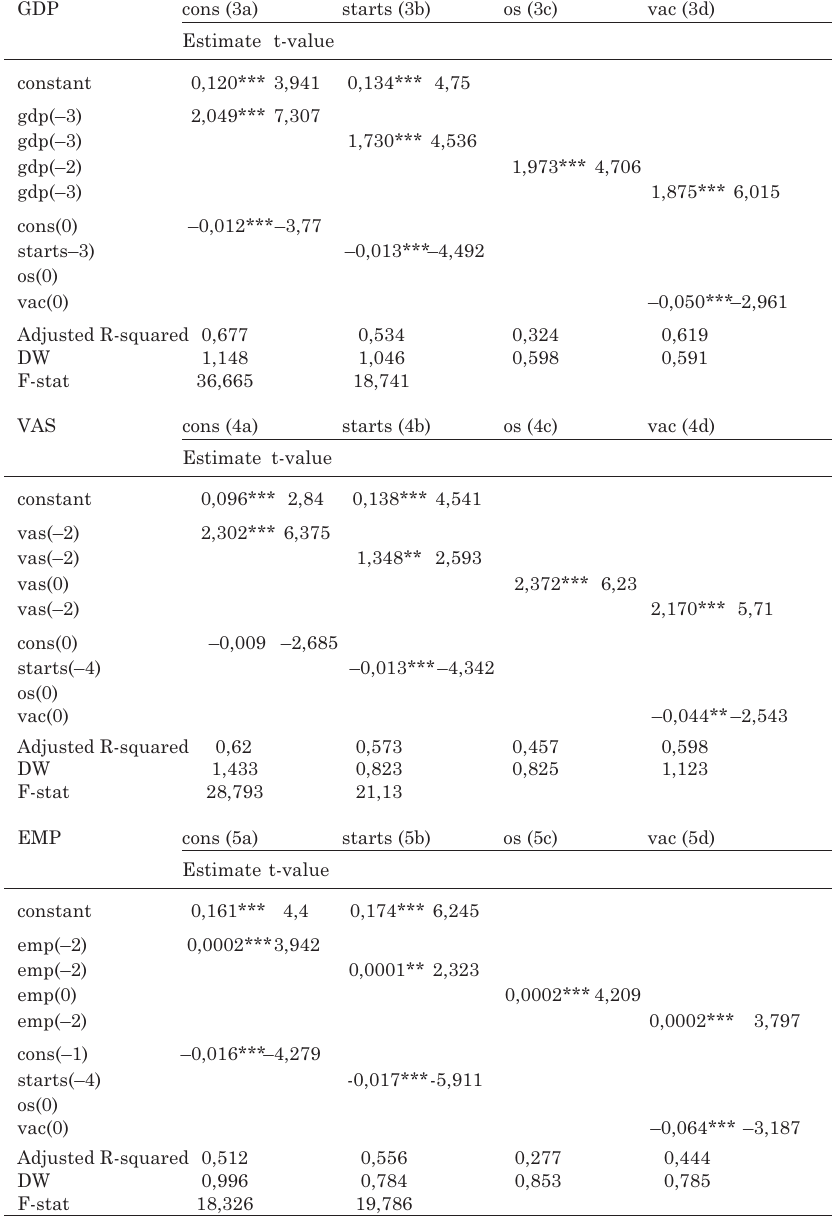
Table 1. Estimation of the alternative models